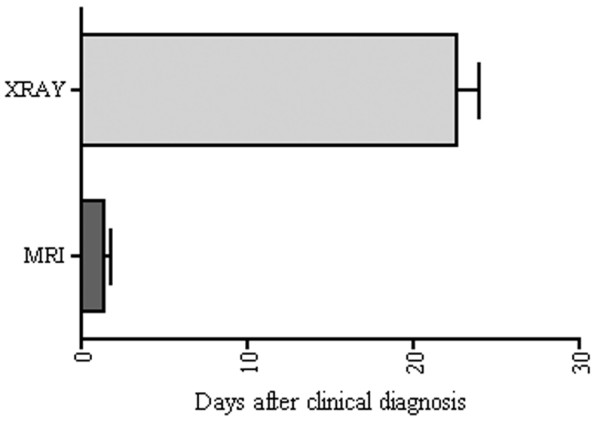
Delay in the emergence of radiological signs after the clinical diagnosis of heterotopic ossification. The difference between magnetic resonance imaging (MRI) and x-ray is statistically significant (p = 0.002).